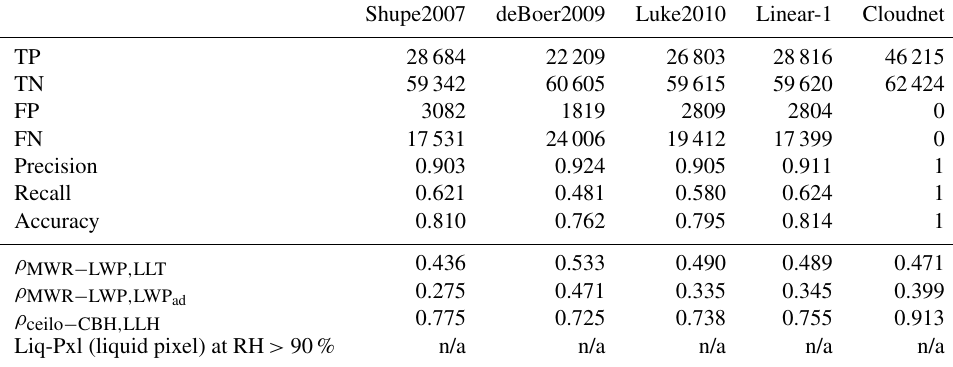
Table 2. Error matrix, performance metrics, and correlation coefficients for MWR-LWP vs. LLT, MWR-LWP vs. LWP ad , and ceilometer CBH vs. LLH, case study 17–18 November. The statistic includes only valid